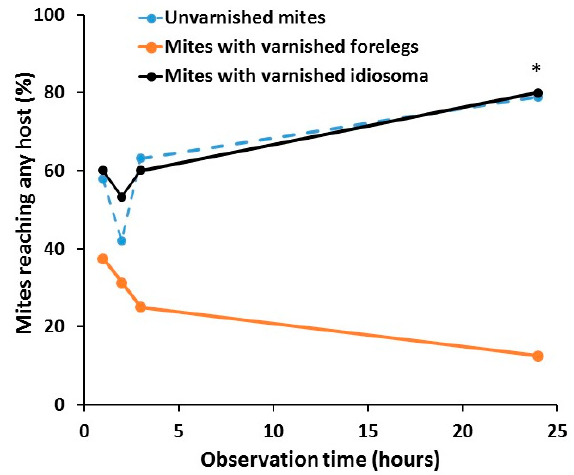
Figure 3. Ability of unvarnished control mites ( n = 19), mites with varnished idiosoma ( n = 15) and mites with varnished forelegs ( n = 19) to reach any of the host bee after 1, 2, 3 and 24 h. The data are percentages of all mites that remained alive (out of 20 mites tested in each group) at the end of the experiment. Asterisk (*) indicates significant difference in the ability to reach any host among the treatment group (Chi-square test, p < 0.05).